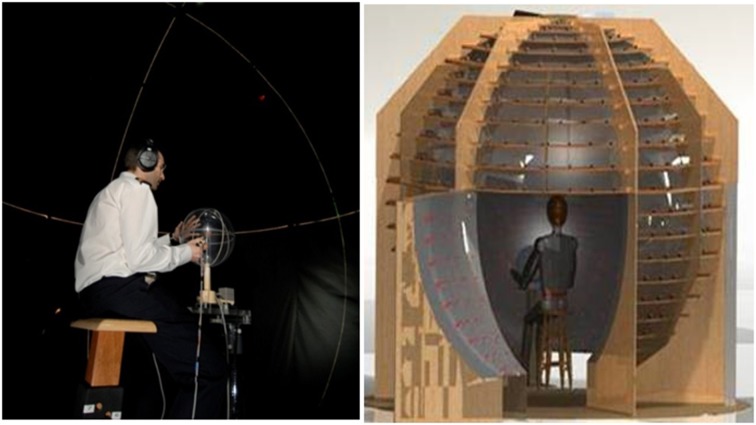
Interior view (left) and exterior schematic view (right) of the experimental apparatus.